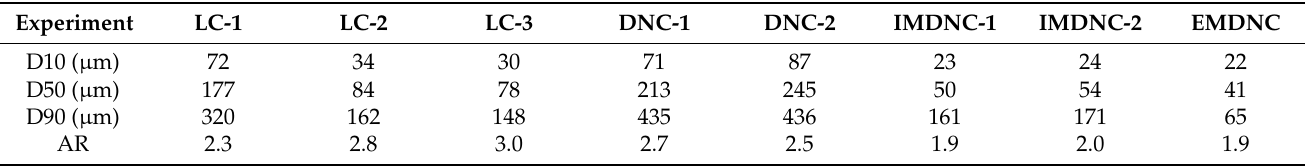
Table 2. Process conditions of crystallization